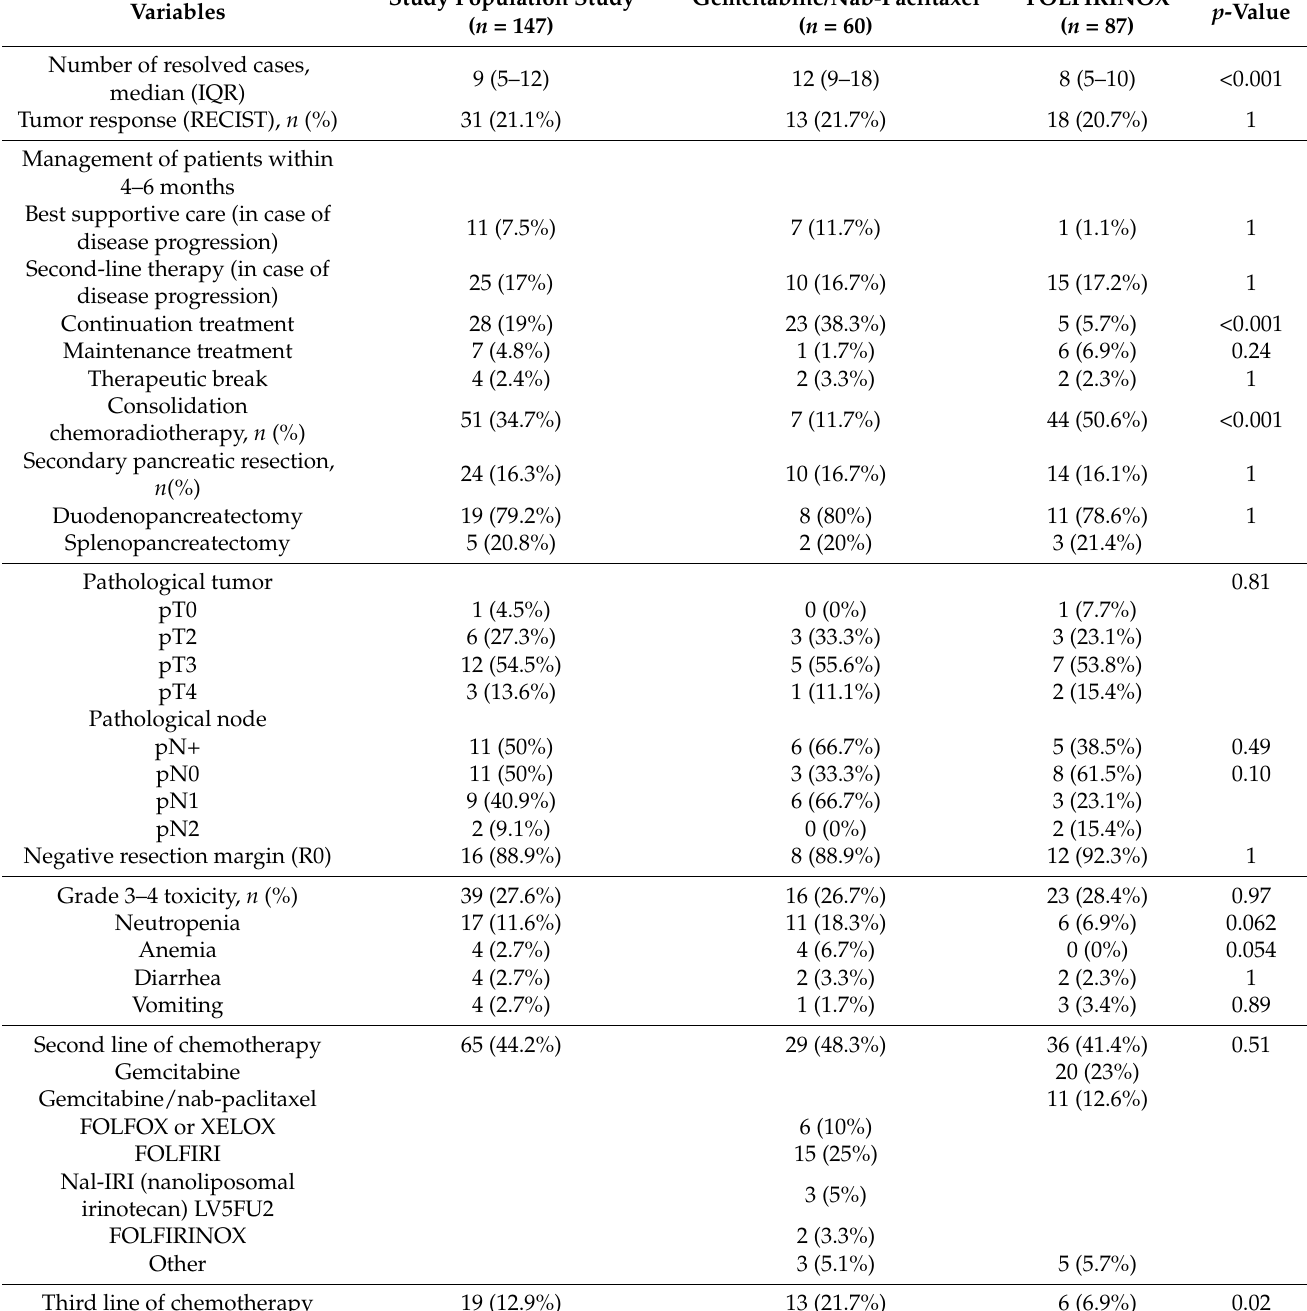
Table 2. Therapeutic sequence and events potentially impacting